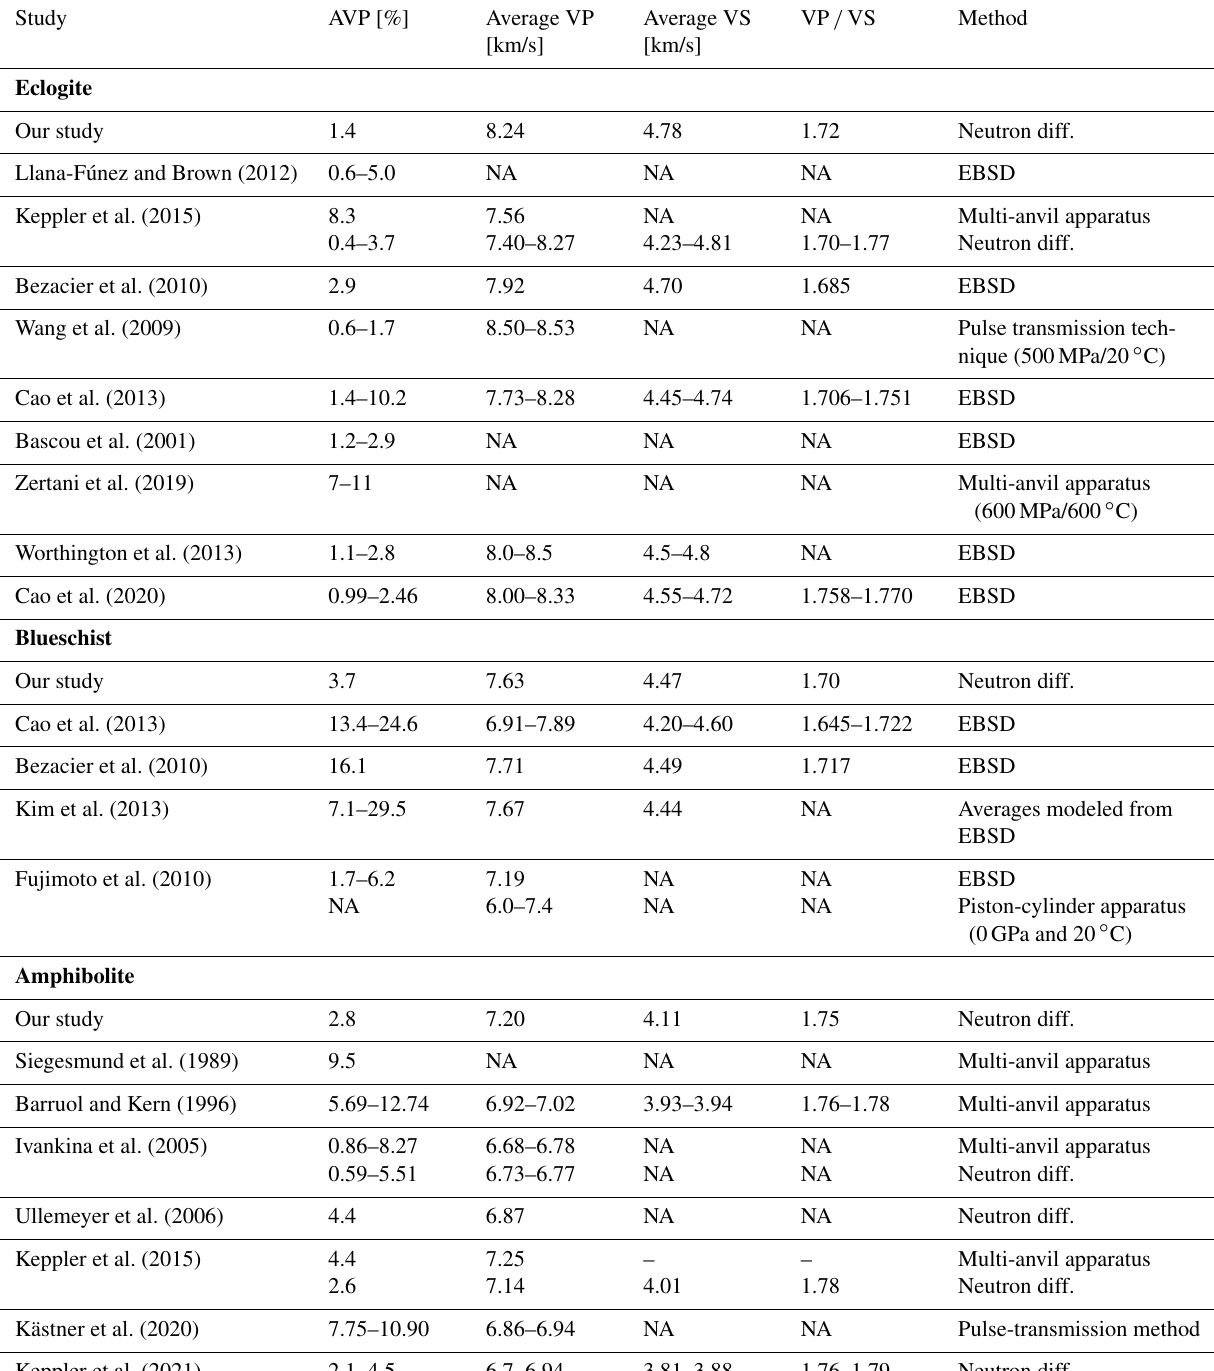
Table 3. AVP [%], average VP, average VS and VP / VS ratios from the literature in comparison to the data from this